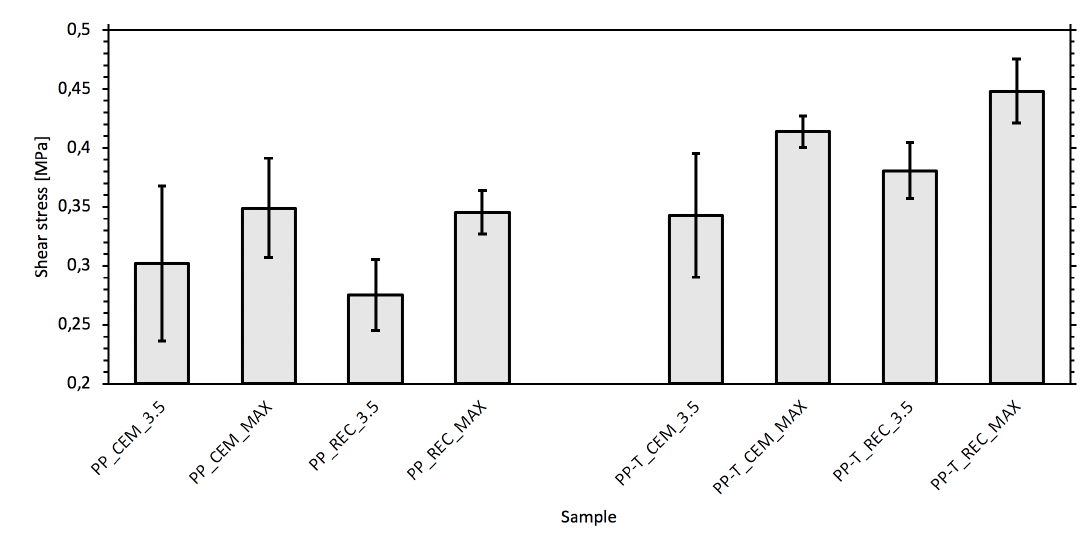
Figure 5. Interfacial shear stress values for different combinations of matrices and PP fibers calculated from the pull-out